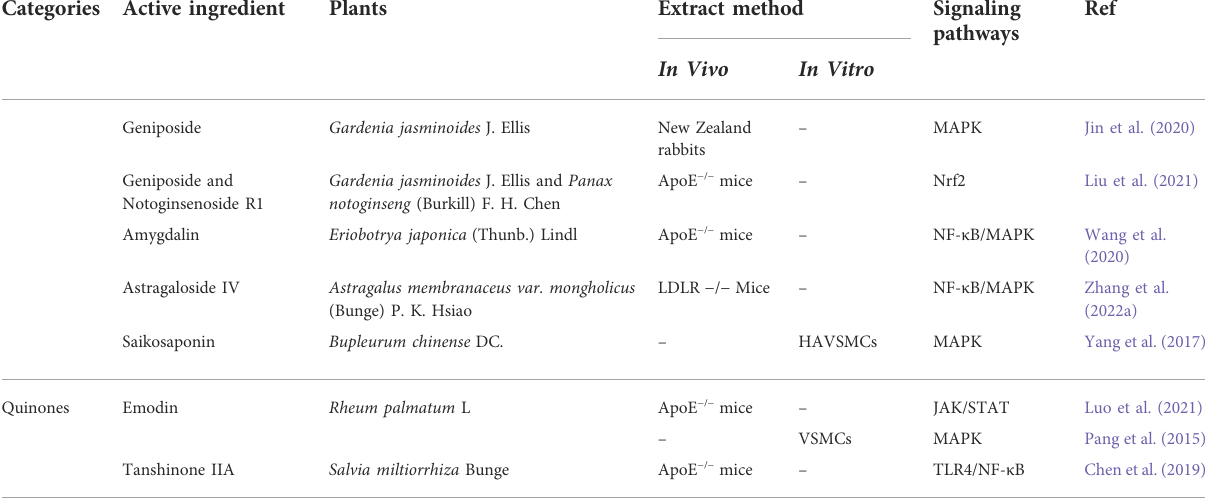
TABLE 1 ( Continued ) Regulatory effects of natural compounds of traditional Chinese medicine on AS-related signaling